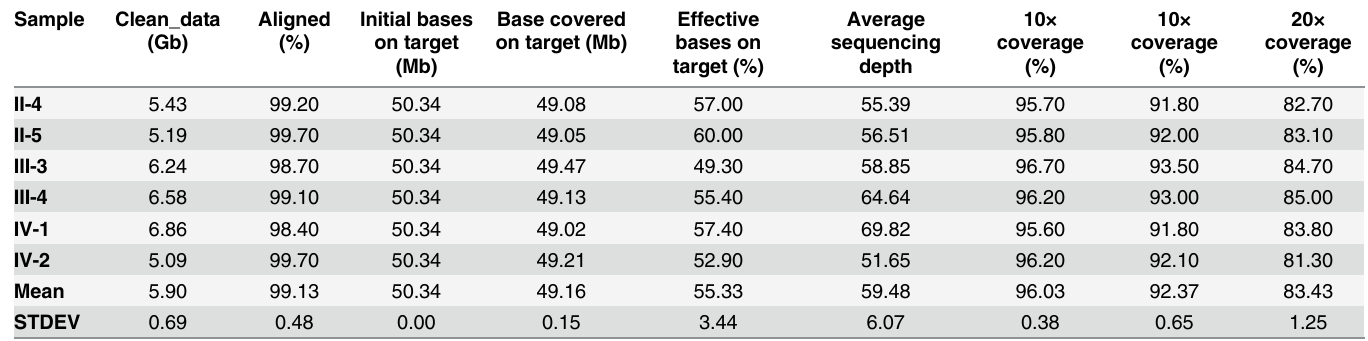
Table 2. Summary of the Exome Sequencing